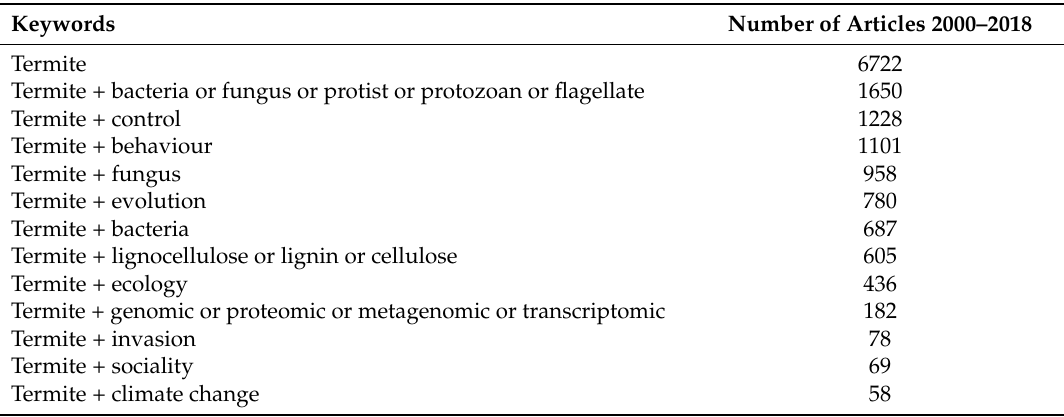
Table 1. Number of articles published in each year between 2000 and 2018 (inclusive) retrieved from Web of Science TM (Thomson Reuters) using termite + one other term (including alternates) as keywords in a topic search, shown in decreasing numerical order. Searched 18 February 2019. Note that any single article may be included in more than one